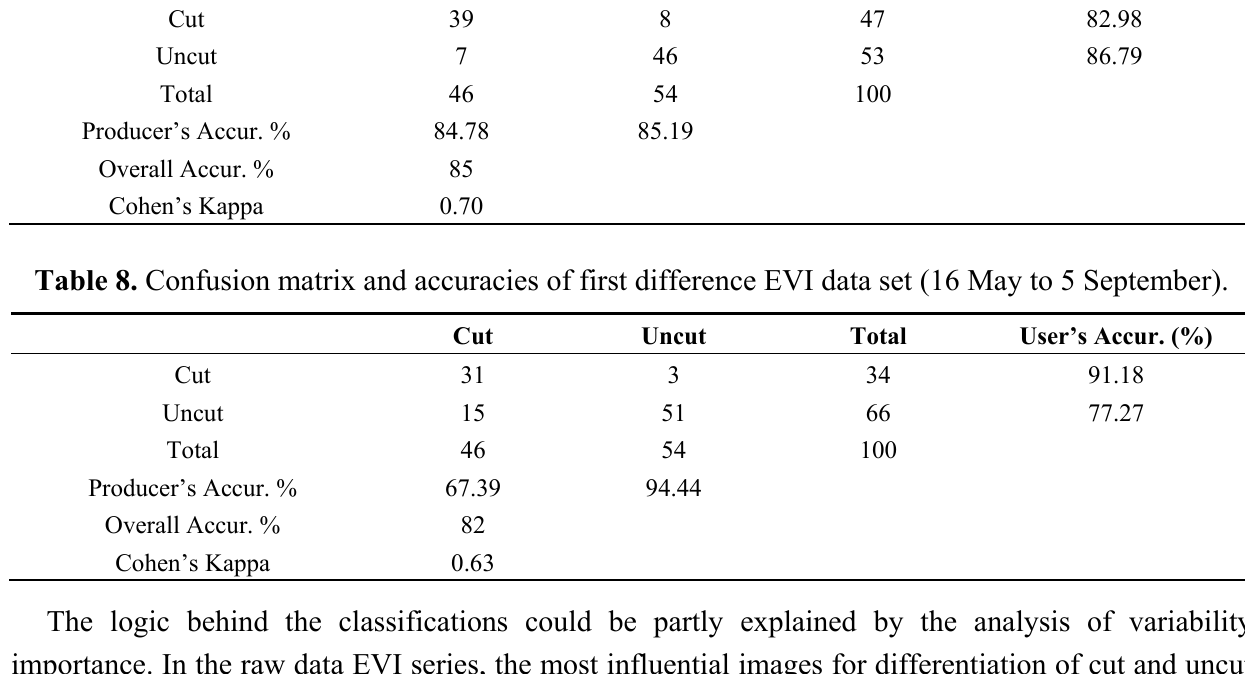
Table 7. Confusion matrix and accuracies of first difference NDVI data set (1 June to 20 August). Cut User’s Accur. (%)